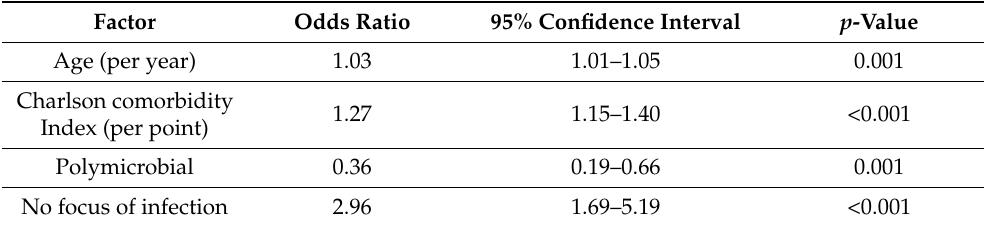
Table 1. Logistic regression modeling of factors associated with 30 days case-fatality in Aeromonas species bloodstream infection. Factor Odds Ratio 95% Confidence Interval p -Value Age (per year)